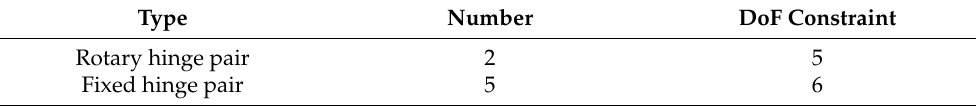
Table 3. Number and types of the restraint pairs of the waste sorting